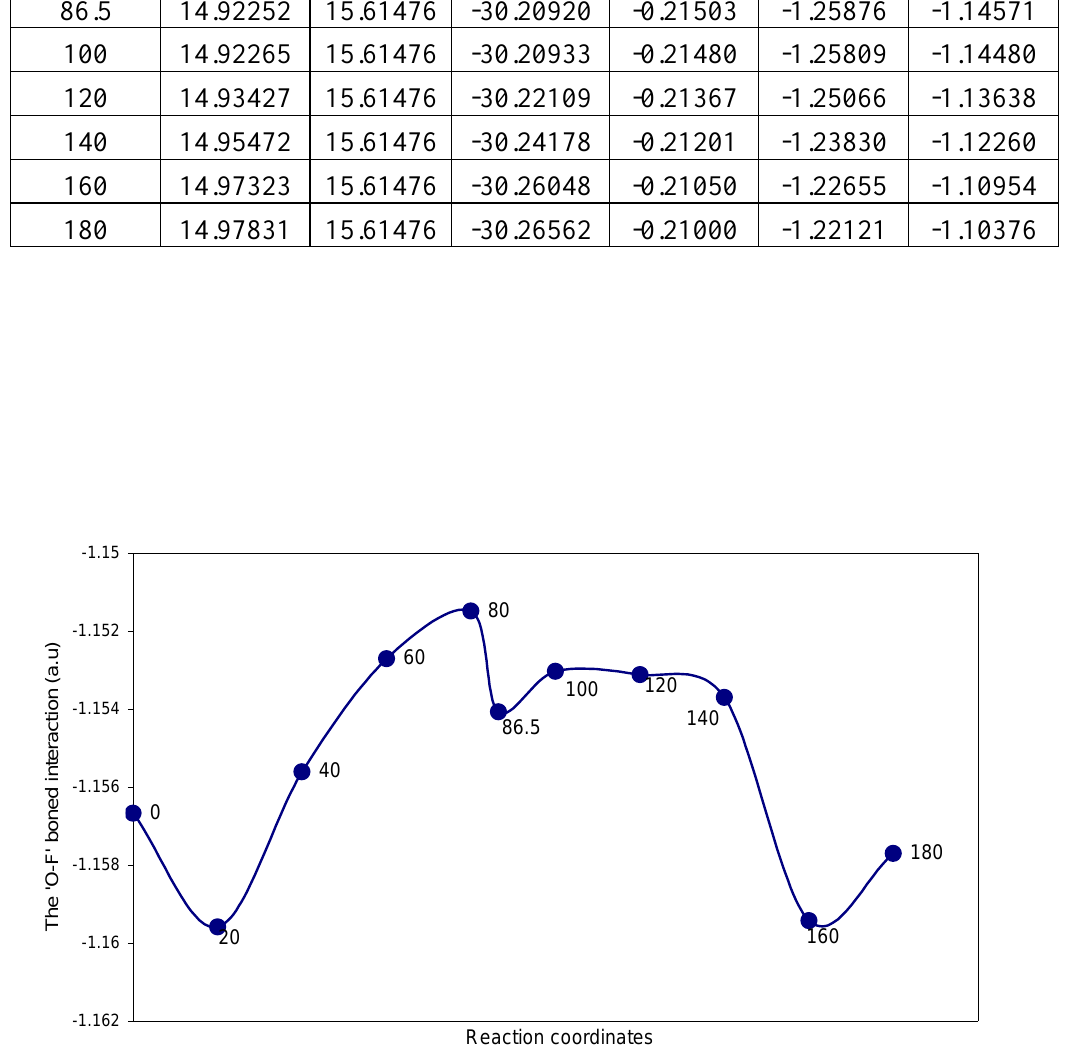
Figure 10. Plot of 'O-F' bonding interaction(a.u) in fluorine peroxide as a function of torsional